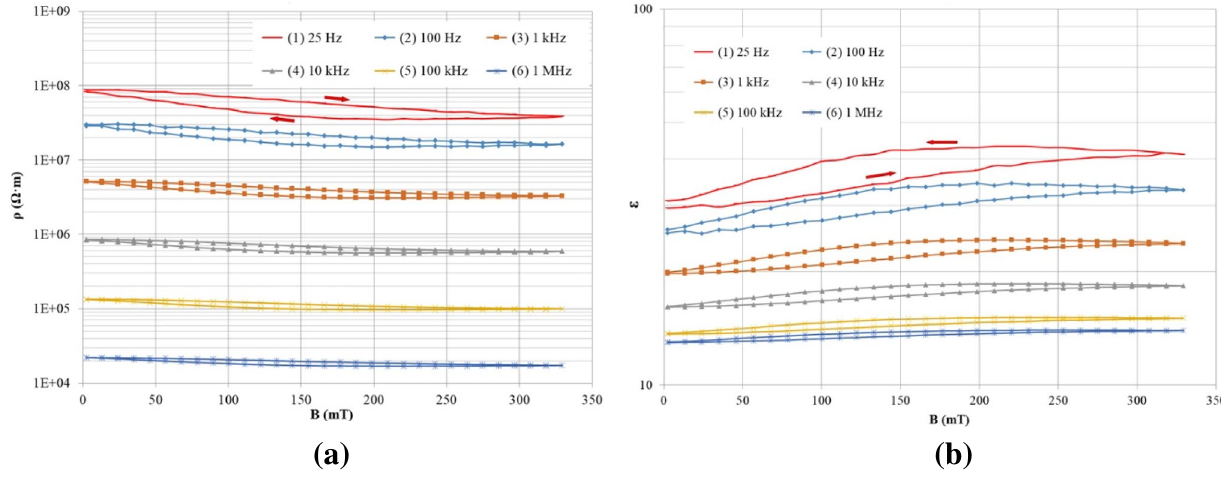
nickel star-like particles. The way the specified parameters change with the field is shown with